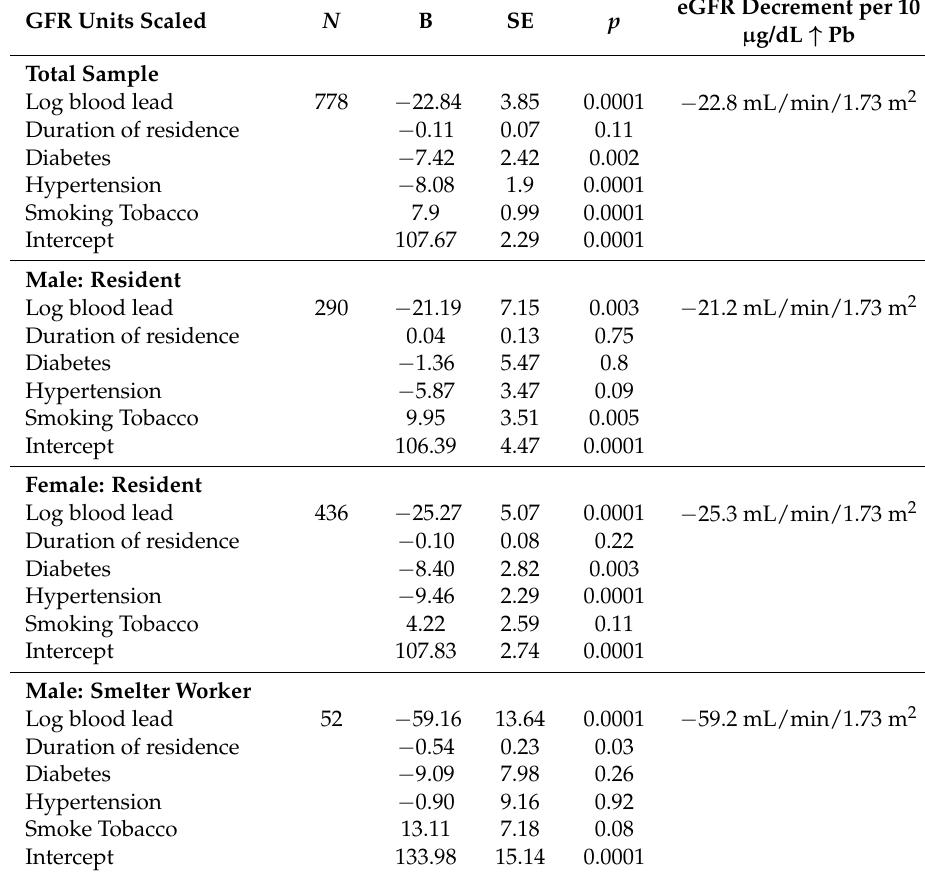
Table 2. Regressions of estimated glomerular filtration rate (eGFR) on log 10 blood lead, duration of residence, diabetes, and hypertension: Effects on Renal